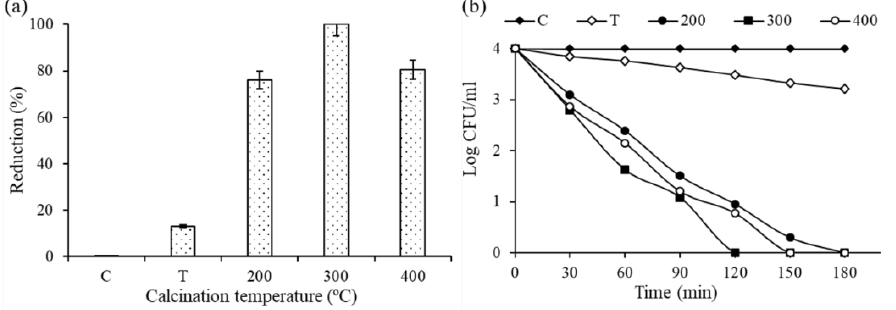
Figure 14. ( a ) Antibacterial performance of TiO 2 (T) and 0.1Fe-TiO 2 photocatalysts calcined at different calcination temperatures; ( b ) kill time analysis log CFU mL − 1 of E. coli. ** C = control, T = TiO 2 -300, 200 = 0.1Fe-TiO 2 -200, 300 = 0.1Fe-TiO 2 -300 and 400 = 0.1Fe-TiO 2 -400.